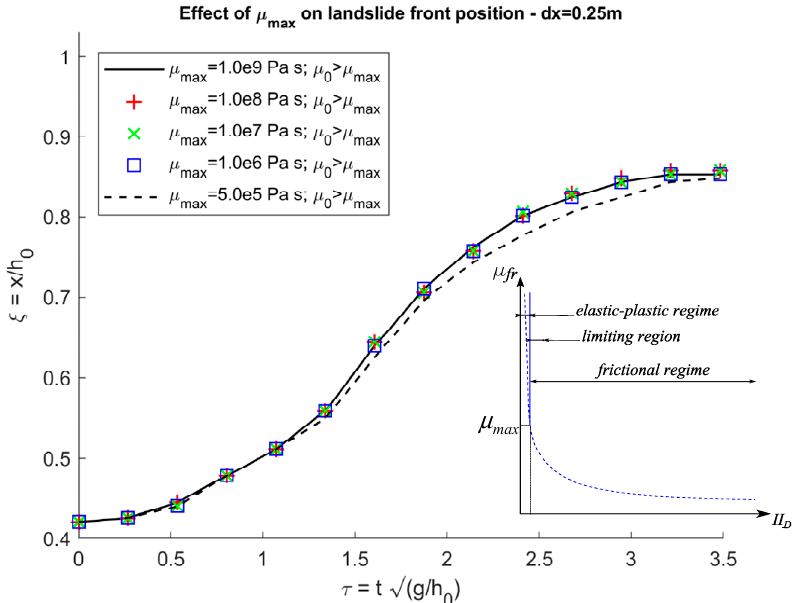
Figure 2. E ff ect of maximum viscosity µ max on landslide front propagation. Non-dimensional front Figure 2. Effect of maximum viscosity μ max on landslide front propagation. Non-dimensional front position ξ as a function of the non-dimensional time τ position ξ as a function of the non-dimensional time τ .